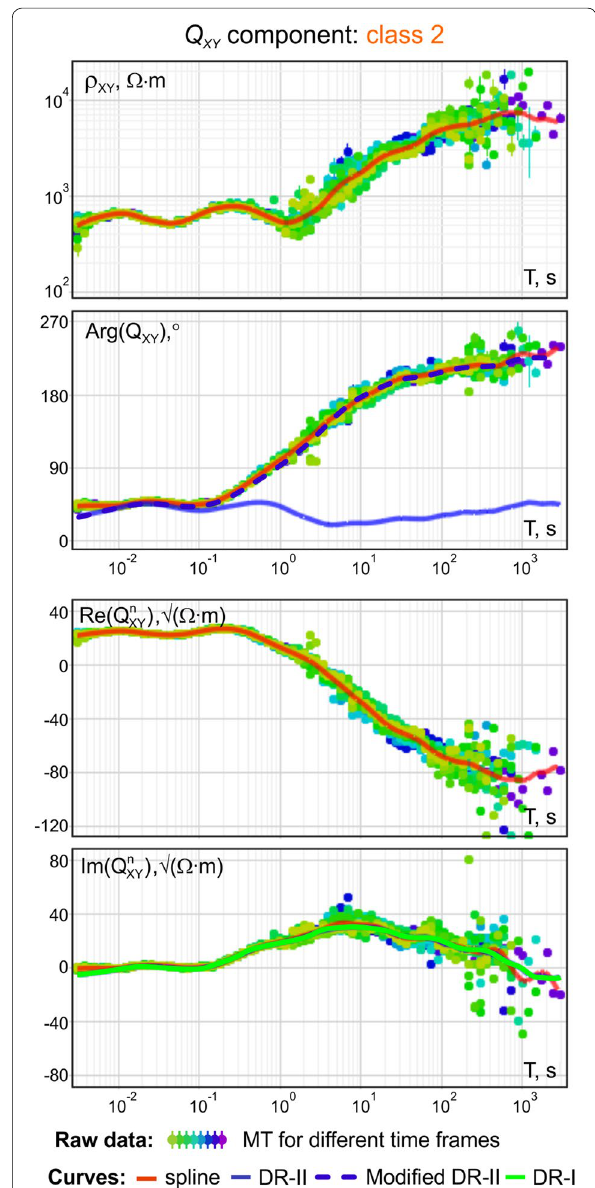
Fig. 16 The DR application to the Q xy transfer function observed at site 28-002 in Yakutia,